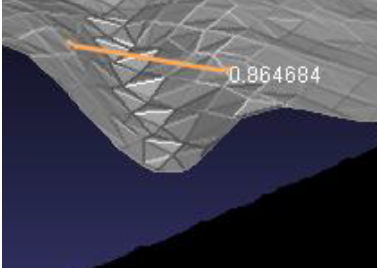
Figure 2: Detail of a sign in the 3D model produced (the scale is expressed in millimeters)